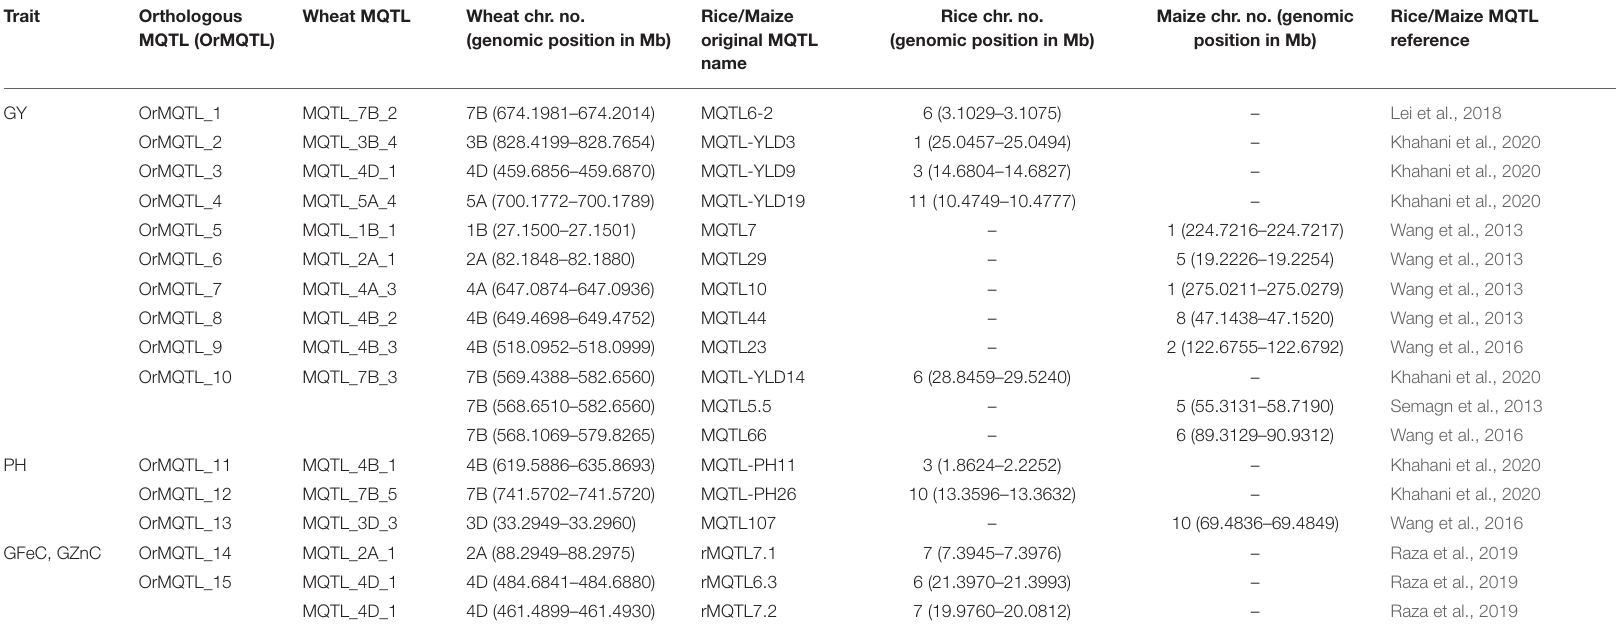
TABLE 5 | The OrMQTLs detected in rice and maize according to the syntenic region with MQTLs in wheat. Trait Orthologous MQTL